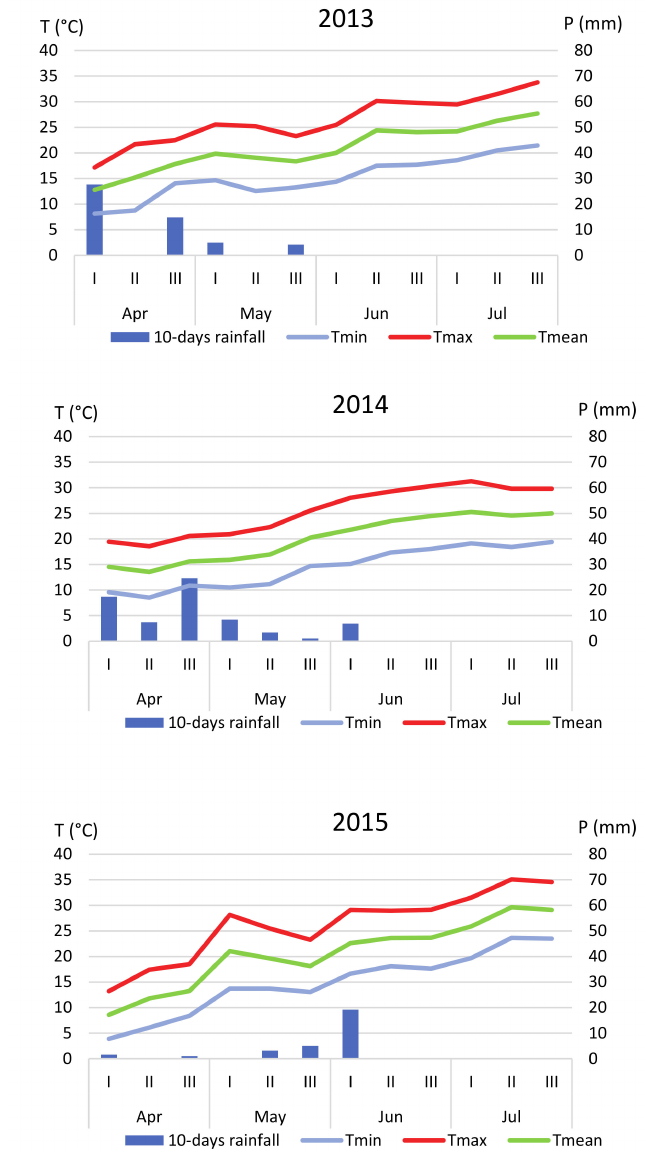
Figure 7. Ten-day values of rainfall (mm) and temperatures ( ◦ C) recorded from April to July in 2013, 2014 and 2015 in the meteorological station “Scibica” (farms 1 and